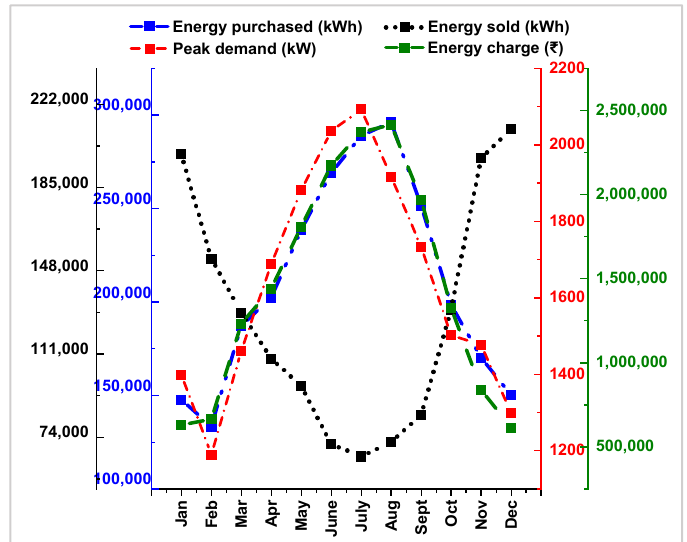
Figure 13. Annually averaged monthly energy metrics.